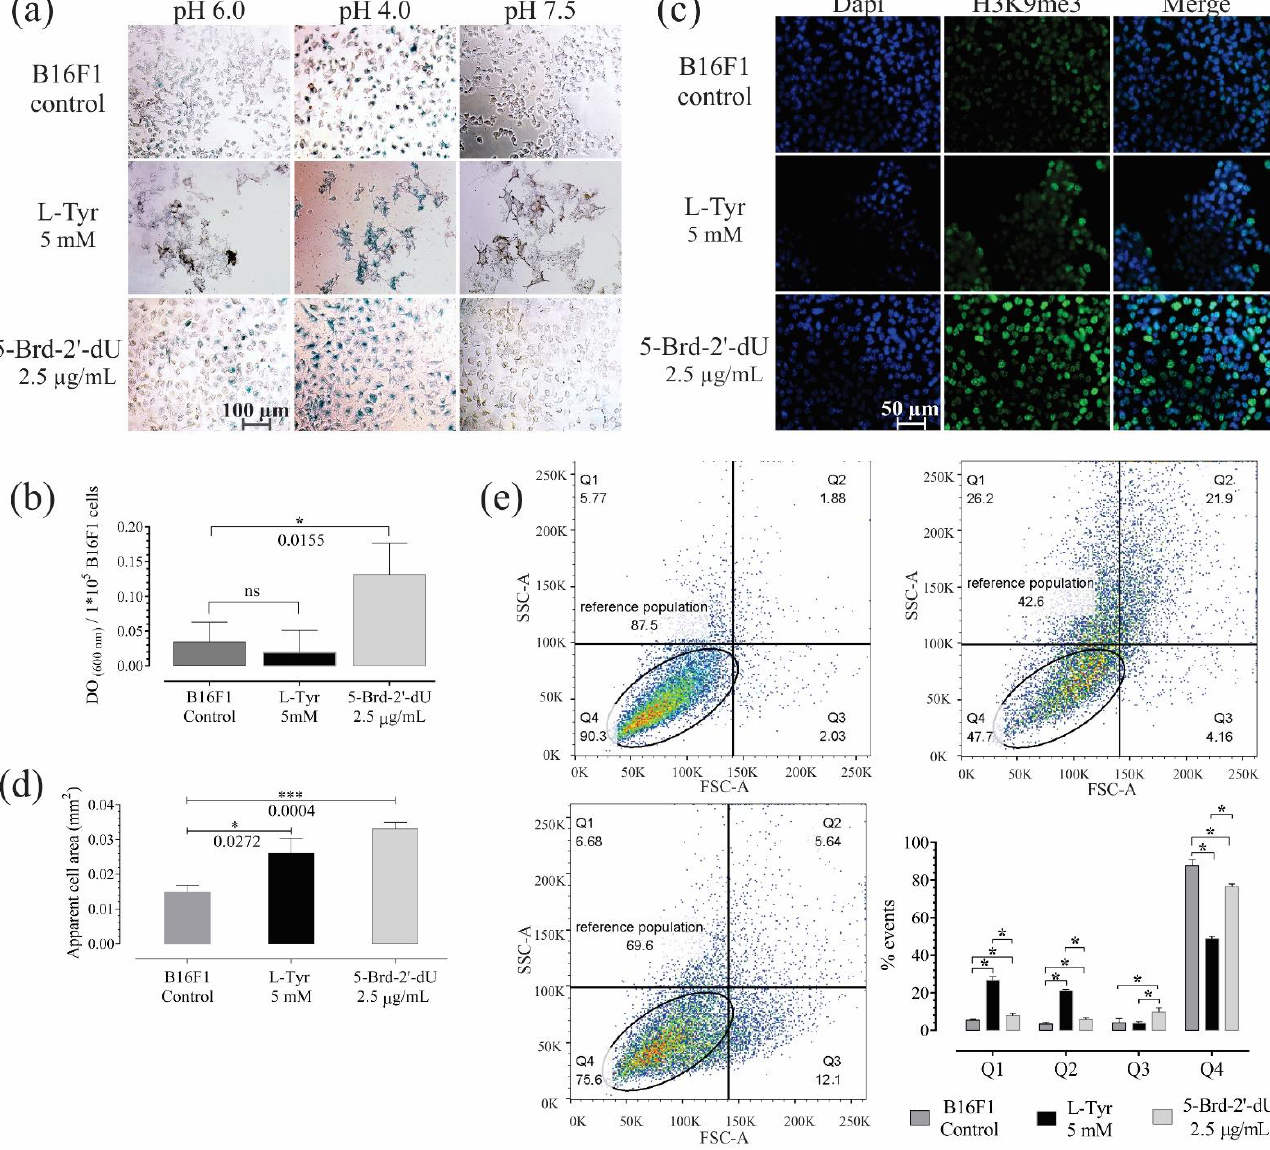
Figure 2. B16F1 cells exposed for 72 h to 5-Brd-2′-dU reveal changes in markers associated with senescence. ( a ) Representative photographs of B16F1 cells after the chromogenic assay for senescence-associated β -Galactosidase activity (S.A. β-Gal). ( b ) Quantification by spectrophotometry of the S.A. β -Gal activity at pH 6.0. ( c ) Representative photographs of immunofluorescence (IF) in B16F1 cells labeled against histone H3K9me3 (green) and nucleus staining with DAPI (blue). ( d ) Measurement of the apparent cell area in µ m2 from bright-field photographs of 100 B16F1 cells ( n = 3). ( e ) Diagram of cell complexity (SSC-A) and size (FSC-A) acquired by flow cytometry and its distribution by quartiles (Q1, Q2, Q3, and Q4). The significance level (*) using two-tailed multiple t -tests, and the differences were considered statistically significant for a p -value < 0.05 using the Holm–Sidak method. Significant (*) with p < 0.05, significant (***) with p < 0.001.